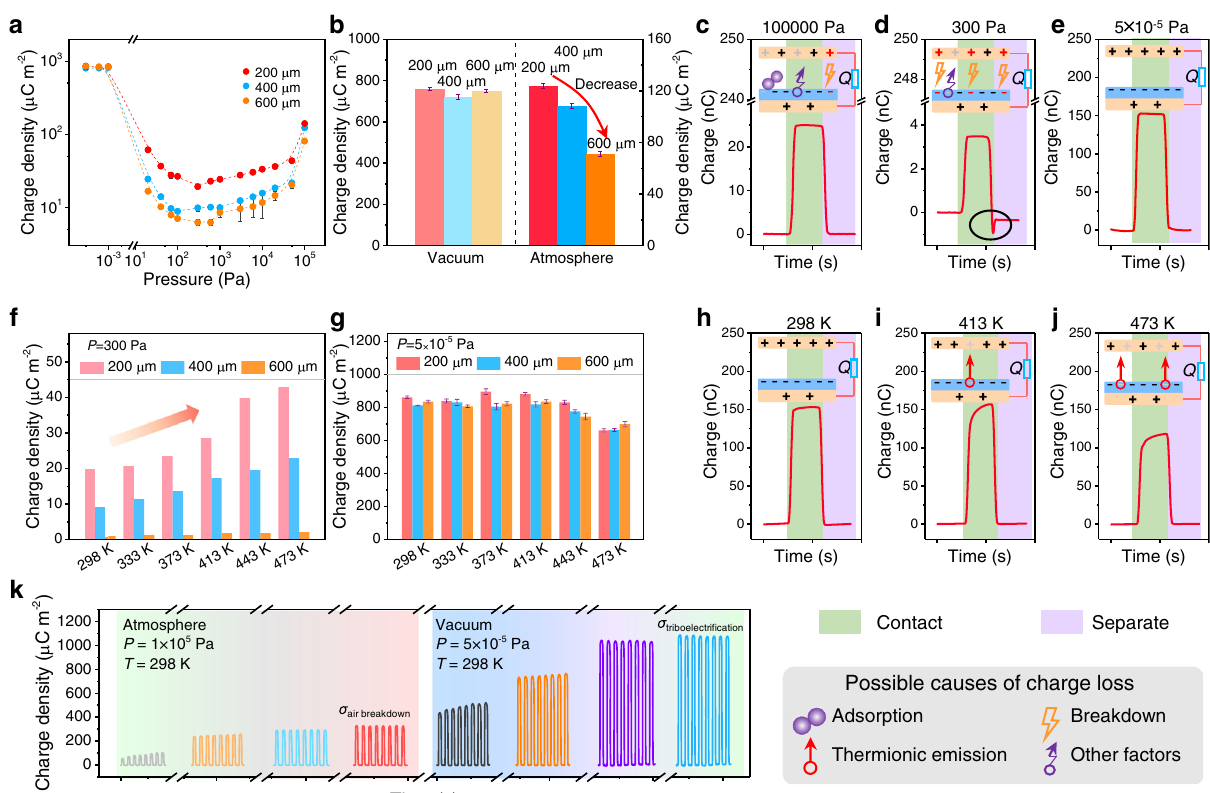
Fig.2|Demonstrationthefeasibilityoftheproposedstrategy.a Surfacecharge densityofthe CS-TENG atvarious atmospherepressureswhen the thickness of the PTFE fi lmis200 µ m,400 µ m,and600 µ m. b SurfacechargedensityoftheCS-TENG in vacuum and atmosphere condition when the thickness of the PTFE fi lm is 200 µ m,400 µ m,and600 µ m.Theseresultsindicatethatthesurfacechargedensity of CS-TENG is strongly related with the dielectric thickness in atmosphere condi- tion, while it hasno relationship with the dielectric thicknessin vacuum condition. Represented curves of output charges of CS-TENG in c 100,000Pa, d 300Pa, and e 5×10 − 5 Pa as well as corresponding charge dissipation model. f Surface charge